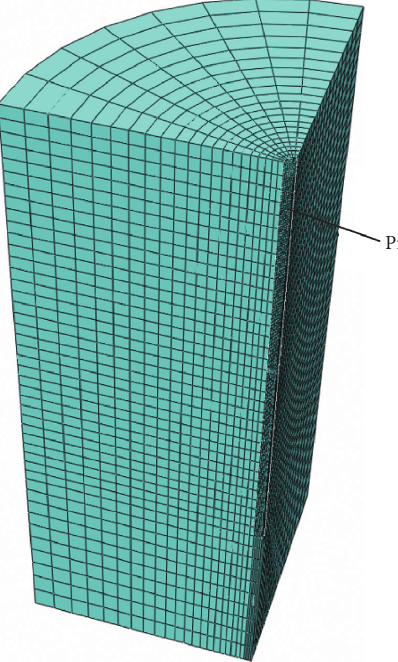
Figure 21: Model of the pile-soil